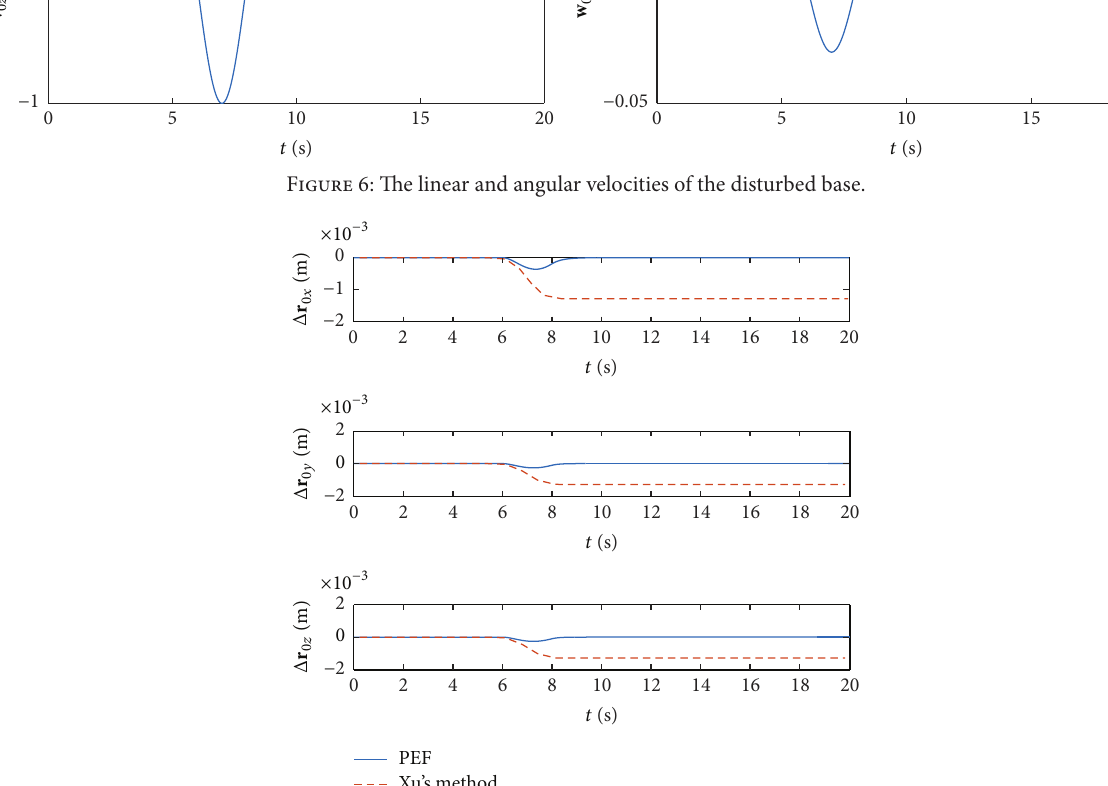
Figure 7: The variation of the base’s positon